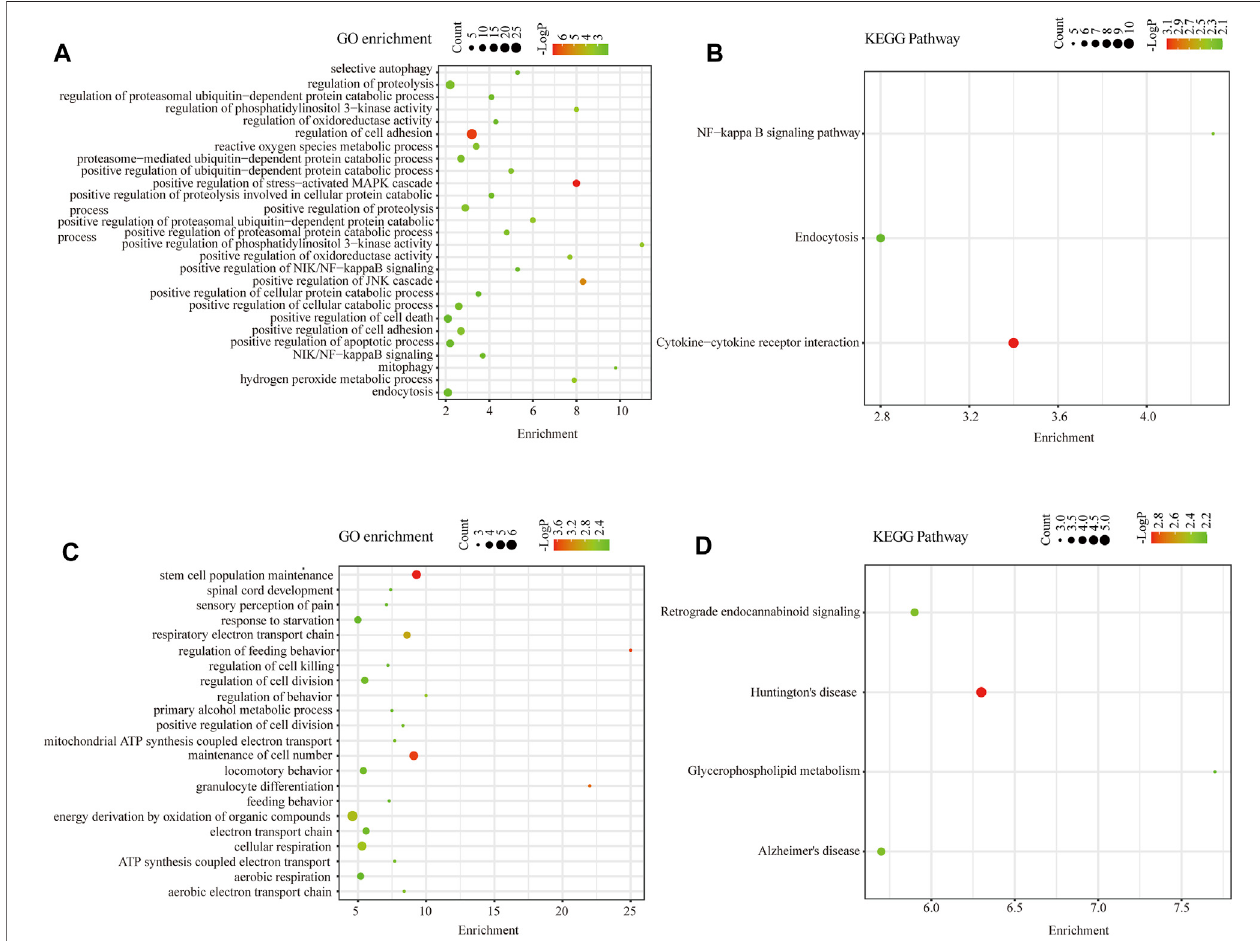
FIGURE4| Functionalenrichmentanalysisofintersected DEGs. (A) GOBiologicalProcess enrichmentanalysisofupregulated intersectedDEGsinKC. (B) KEGG pathway enrichment analysis of upregulated intersected DEGs in KC. (C) GO Biological Process enrichment analysis of downregulated intersected DEGs in KC. (D) KEGG pathway enrichment analysis of downregulated intersected DEGs in